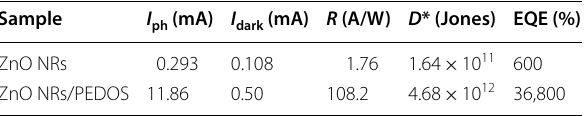
Table 1 Performances of ZnO NRs and ZnO NRs/PEDOS UV PDs under 1 V bias